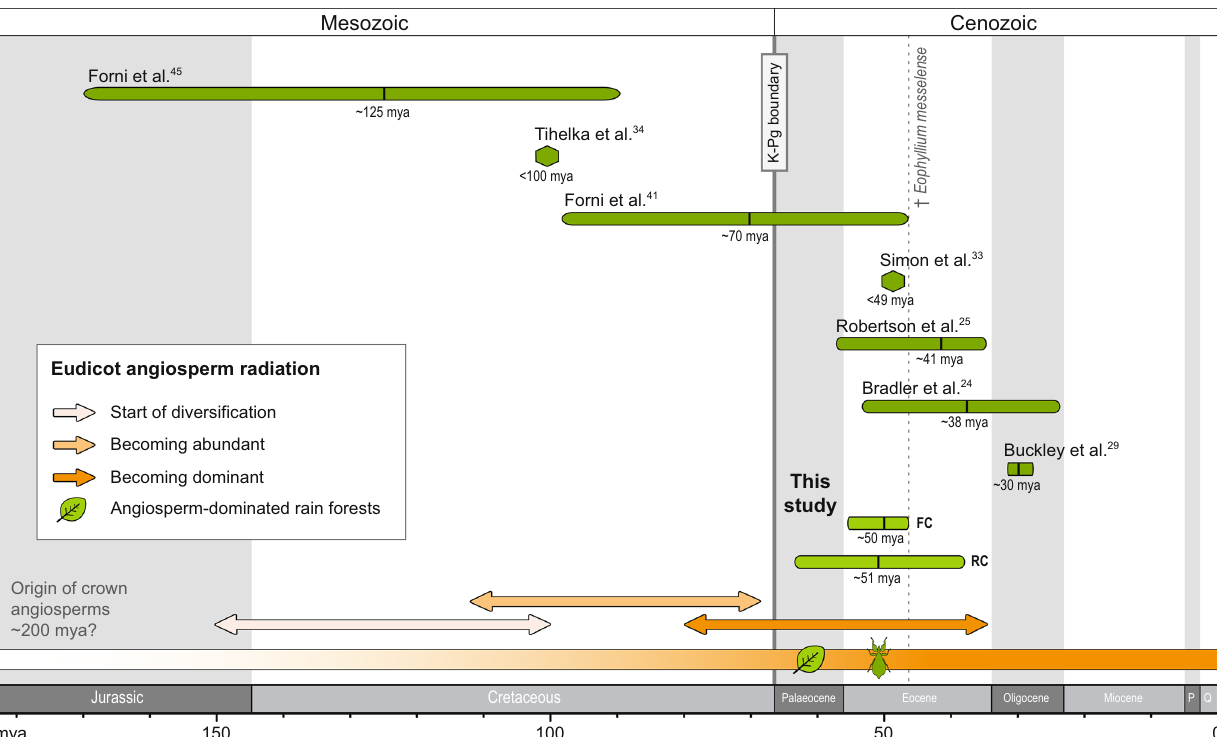
Fig. 4 Geological timeline comparing the divergence time estimates for Phylliidae in relation to the angiosperm radiation. Green con fi dence interval bars are given for each study that estimated a divergence time for leaf insects; hexagonal shapes are depicted when the estimated age is referring to the divergence from the phylliid sister taxon. The radiation of eudicot angiosperm is hypothesised to have started in the Early/Mid Cretaceous 54 – 57, 60 with extant lineages having become abundant until the Late Cretaceous. Dominance over gymnosperms and ferns was probably achieved during the period from the Late Cretaceous to the Early Cenozoic 53, 56 with subsequent emergence of angiosperm-dominated rain forests. FC fossil calibration ( † Eophyllium messelense ), RC root calibration